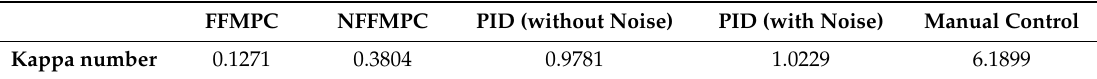
Table 1. Average output error for all the cases.